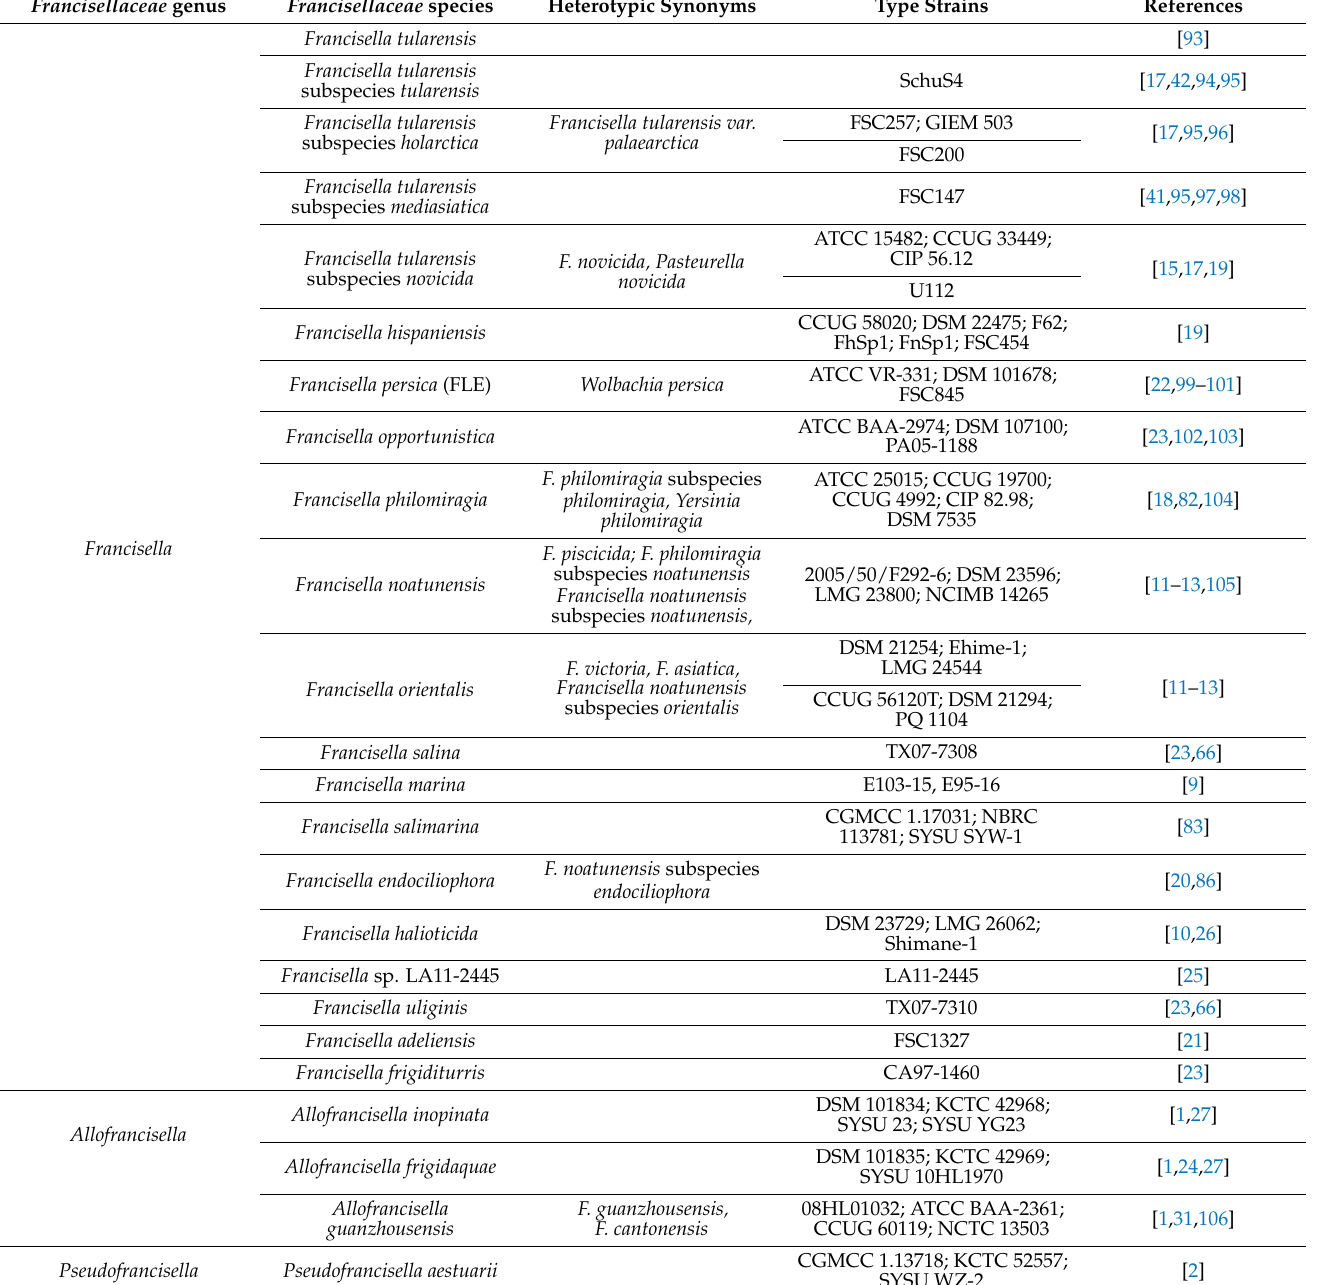
Table A1. Detailed overview of species within family Francisellaceae following NCBI